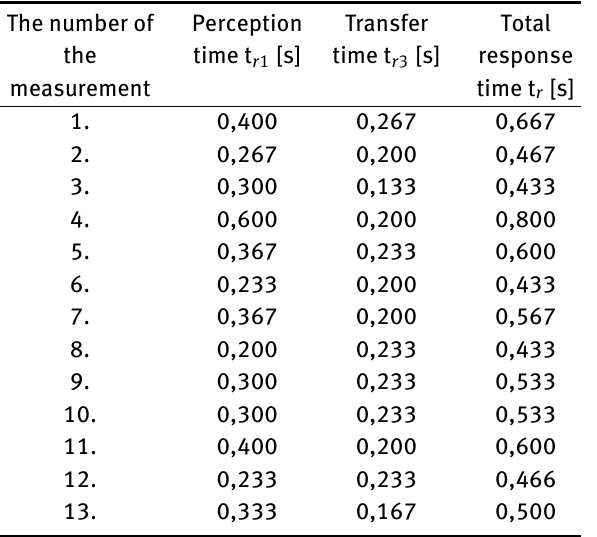
Table 15: Summary of the results of driver J. The number of the